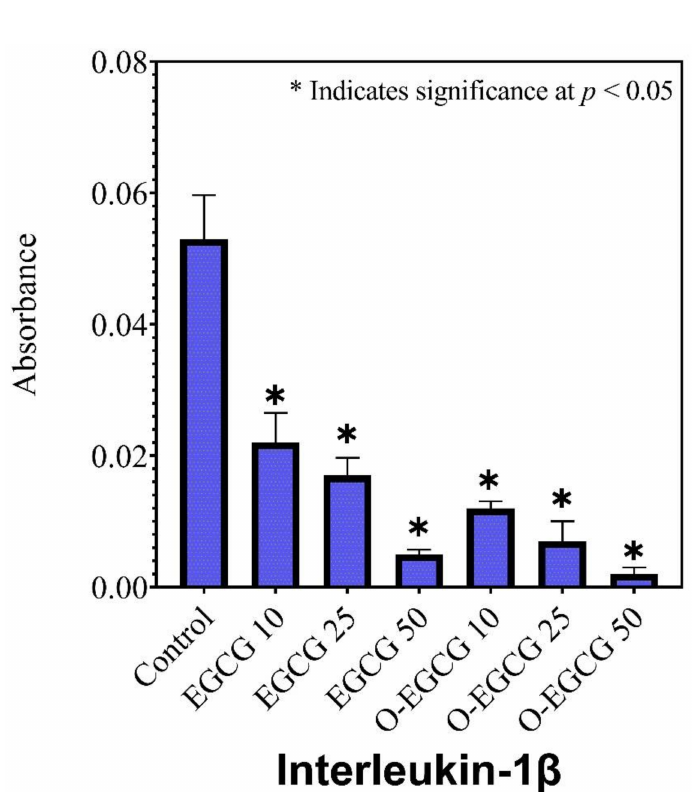
Figure 5. The effect of EGCG and O-EGCG on IL- β production in HCT-116 cells. (* indicates significance at p <